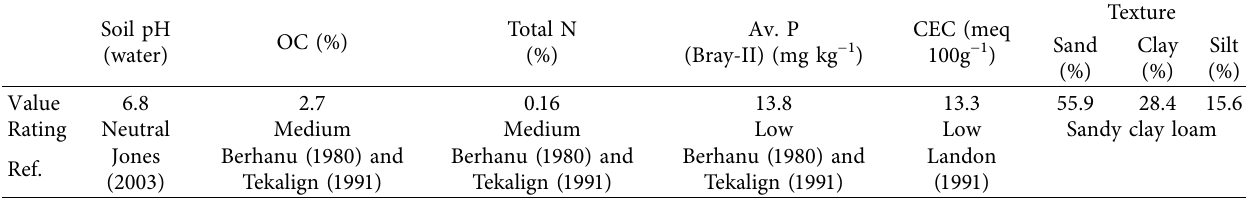
Table 1: Physicochemical properties of the experimental soil.